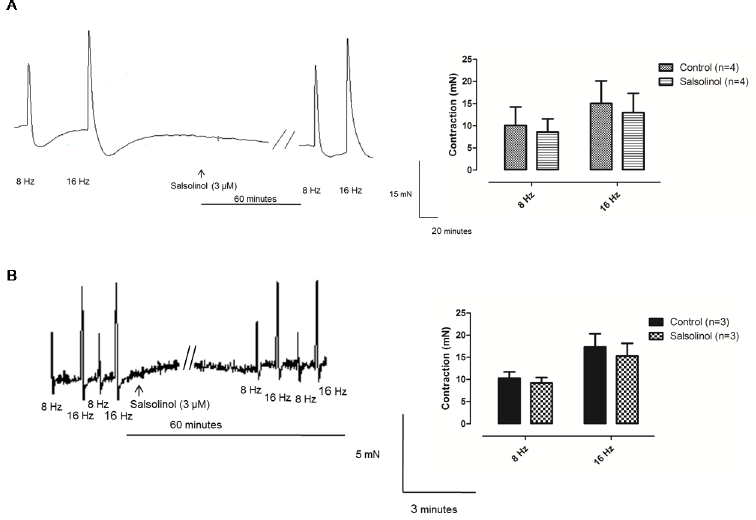
Fig 5. Representative illustrationof EFS-induced contractionof Crotalus (A) and rabbit (B) corpora cavernosain the presenceof salsolinol(3 μ M).